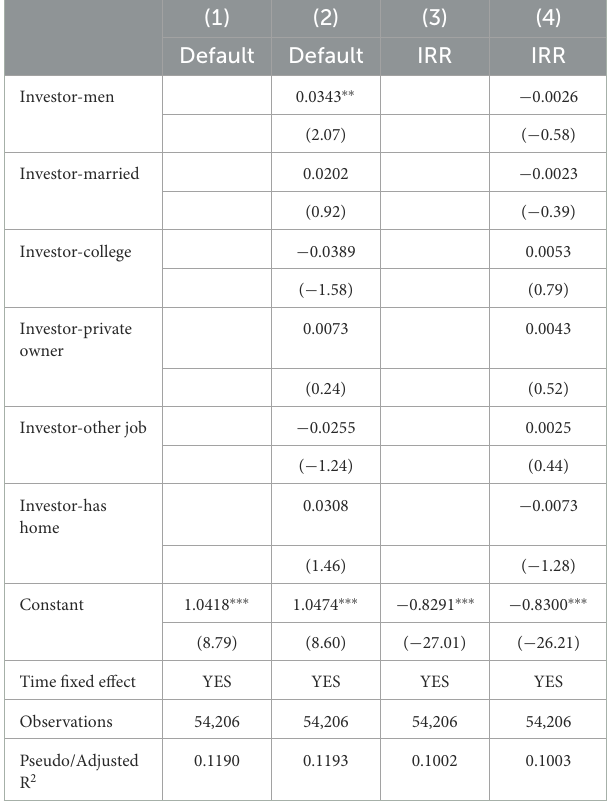
TABLE 2 Relationship between limited attention and investment outcomes: baseline